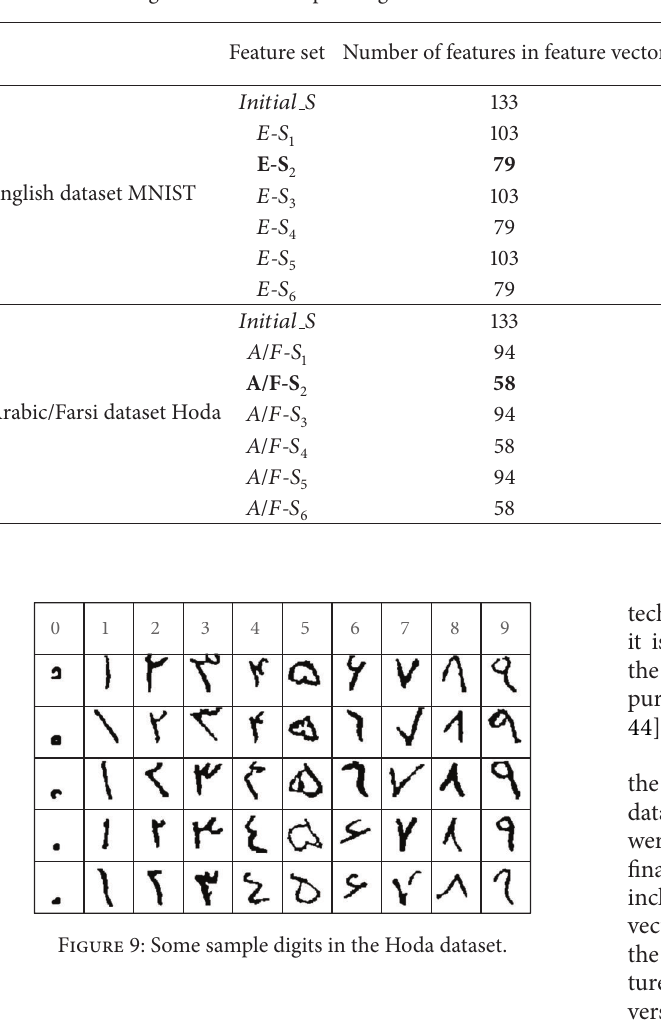
(with 103 features) from the initial feature set, Initial S